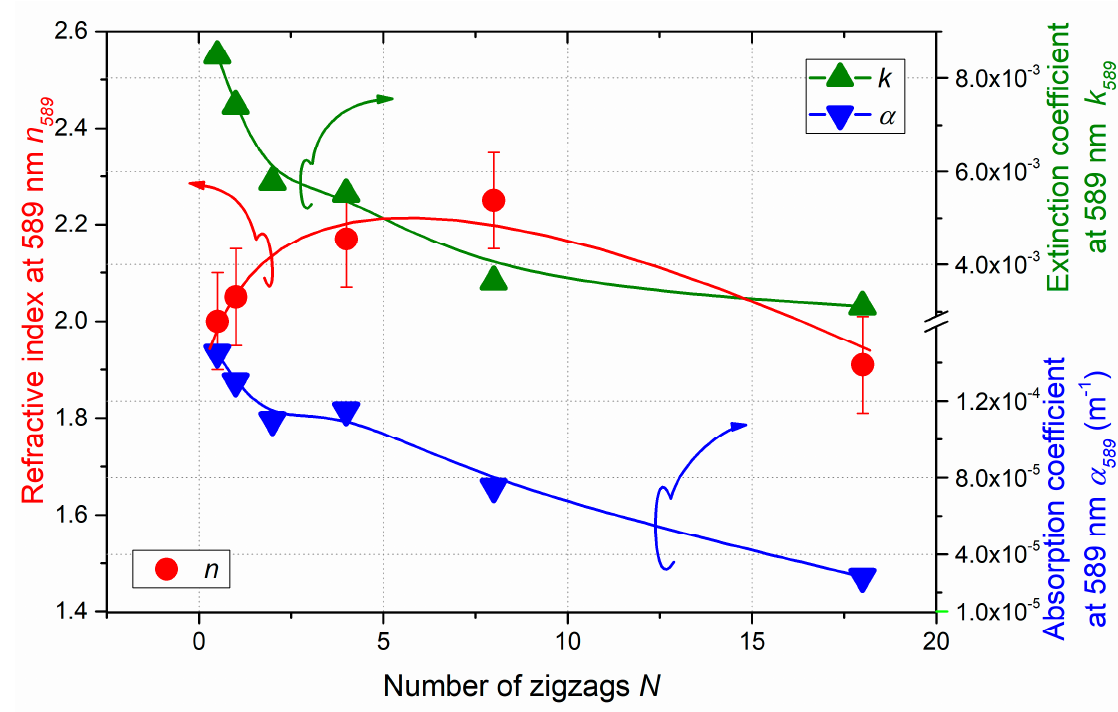
Figure 6. Refractive index, extinction coefficient, and absorption coefficient at 589 nm of WO 3 films vs. number of zigzags N . All films were sputter-deposited with a tilt angle α = 80° and a duty cycle dc = 80% of the pulsing period P . Fit lines are used to guide the eye.